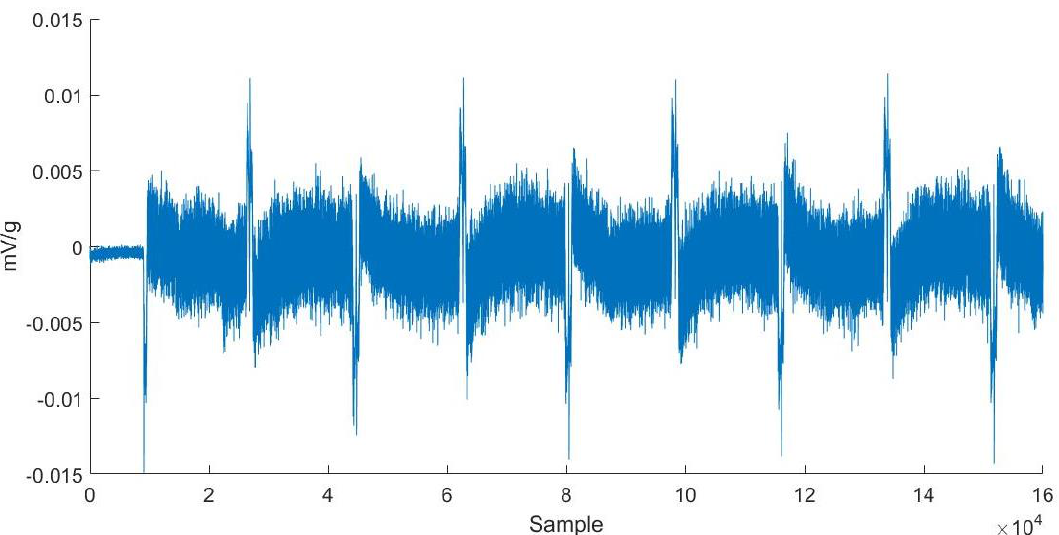
Figure 7. Sampled vibration signals.